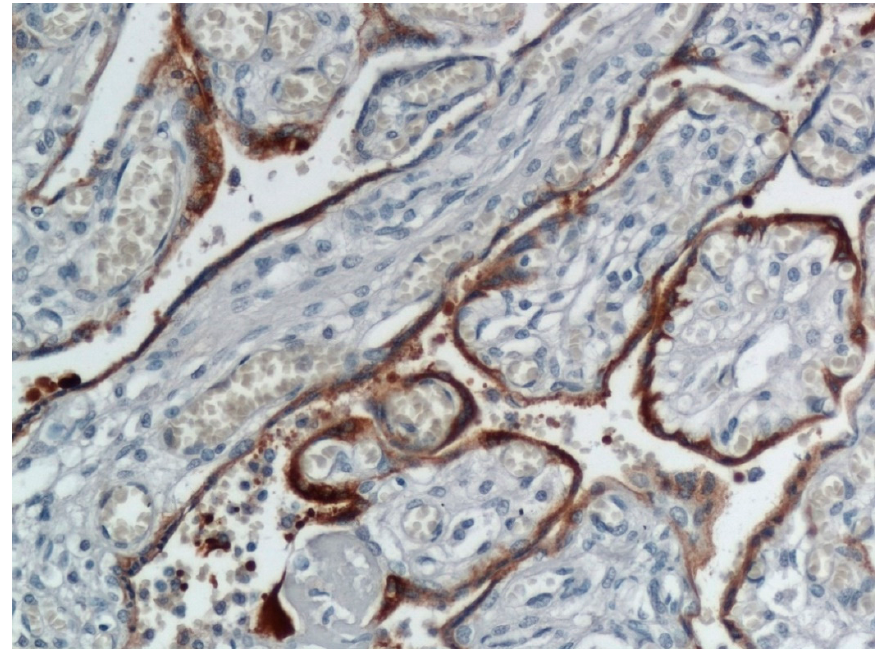
Figure 2. Placenta from the same maternal-neonatal dyad as in Figure 1 in which there was intrauterine maternal-fetal transmission of COVID-19. The confluent areas of brown staining at the periphery of the chorionic villi represents trophoblast infection identified by immunohistochemistry using an antibody to SARS-CoV-2 nucleocapsid protein. Positive staining is also present in inflammatory cells in the intervillous space. This placenta was described in [23]. ×20 magnification.